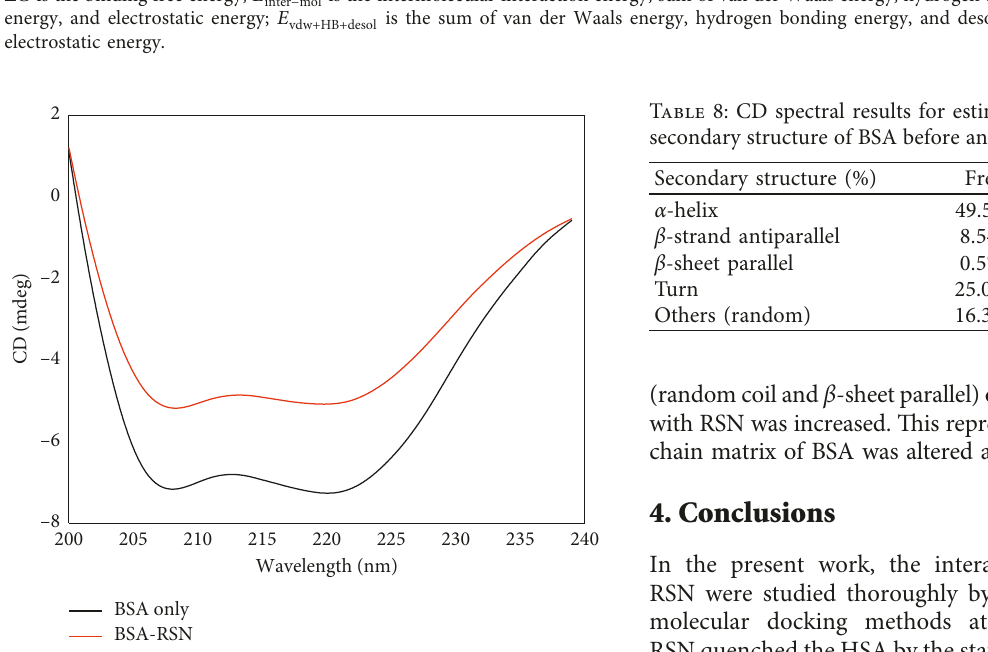
Figure 11: CD spectra of free BSA (black line) and BSA-RSN complex (red line) at pH 7.40 and 297K. Concentration of BSA:RSN � 1:20 (3 . 5 × 10 − 6 to 70 × 10 − 6 mol · L − 1 ).